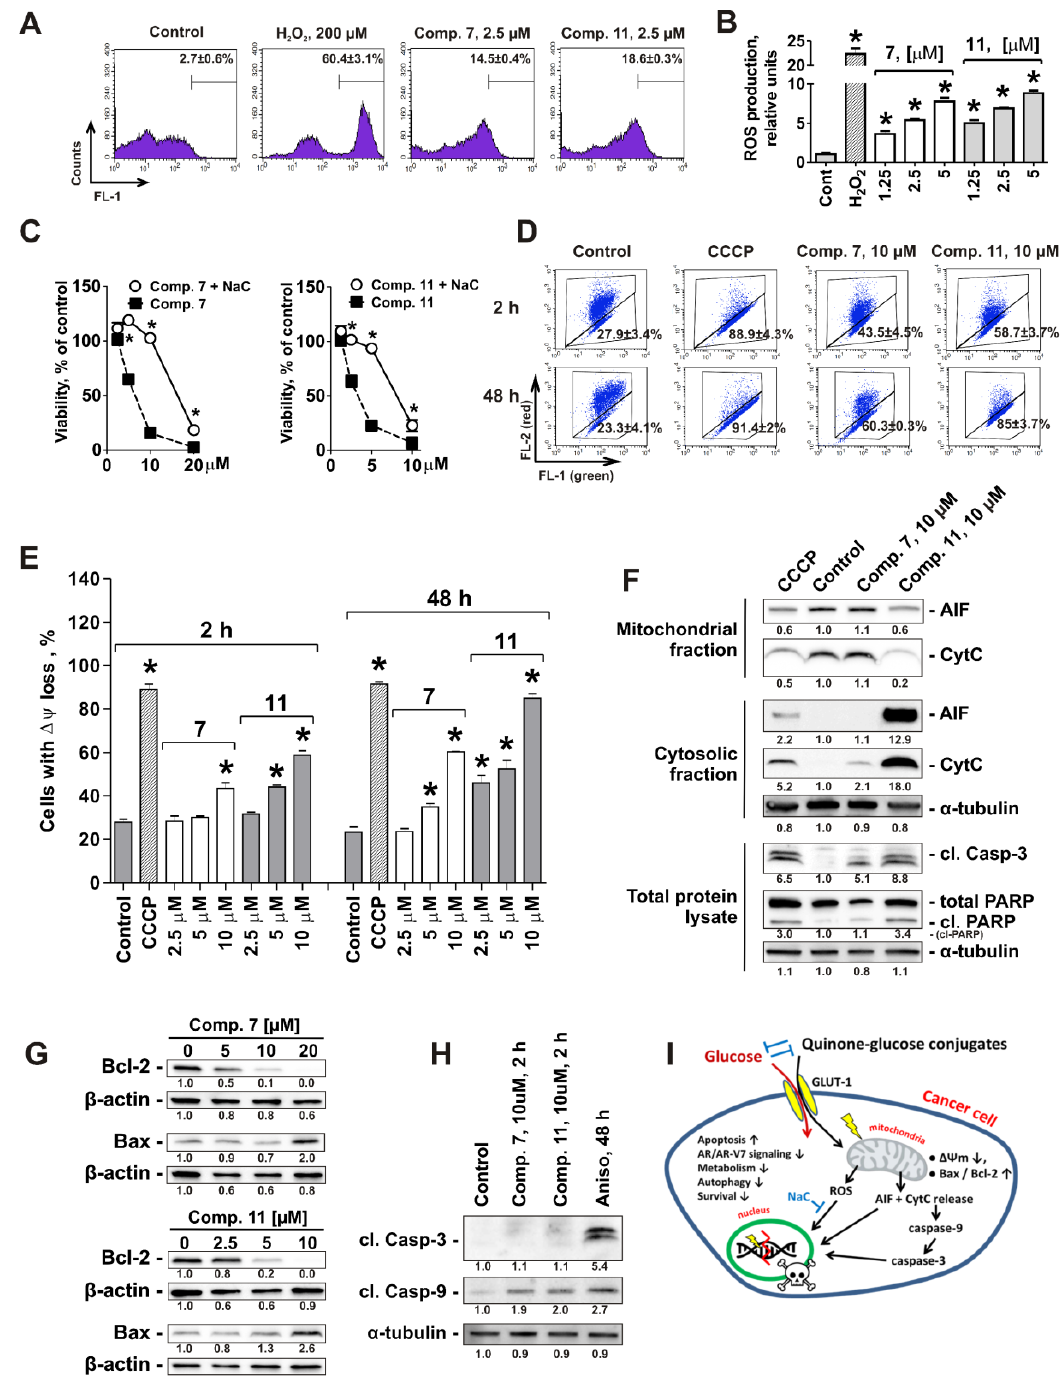
Figure 5. Quinone-glucose conjugates 7 and 11 primary target mitochondria of human prostate cancer cells. ( A , B ) Effect on ROS production in 22Rv1 cells. Cells were pretreated with CM-H 2 DCFDA followed by treatment with indicated concentrations of the investigated drugs for 2 h. Cells were harvested, analyzed by flow cytometry technique ( A ) and quantified using the Cell Quest Pro software ( B ). H 2 O 2 -treated cells were used as a positive control. ( C ) Effect of N-acetyl-L-cysteine (NaC) on the cytotoxicity of compounds 7 and 11. 22Rv1 cells were pre-treated with 1 mM NaC for 1 h and then co-treated with the investigated drugs for 48 h in FBS- and glucose-free RPMI media. Cell viability was measured by MTT test. ( D , E ) The induction of mitochondrial membrane potential (MMP, ∆Ψ m) loss by the drugs. 22Rv1 cells were treated for either 2 h or 48 h in PBS, harvested, stained with JC-1